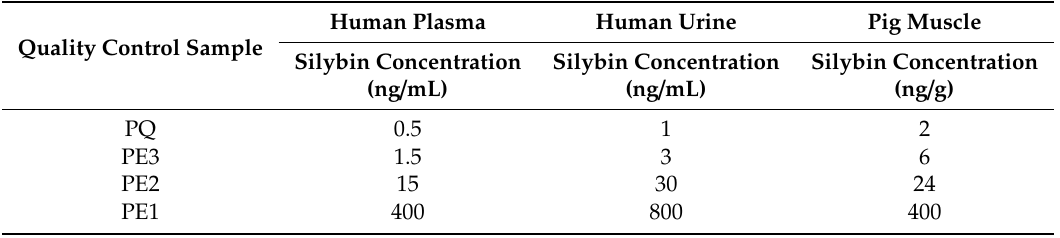
Table 4. Quality control samples and silybin concentrations in human plasma, human urine, and pig muscle